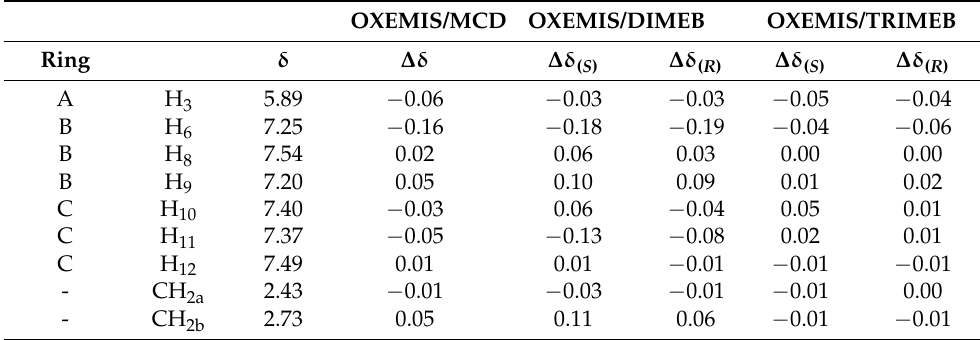
by the presence of OXEMIS than external ones were (Table 3), as a clear indication of the occurrence of inclusion